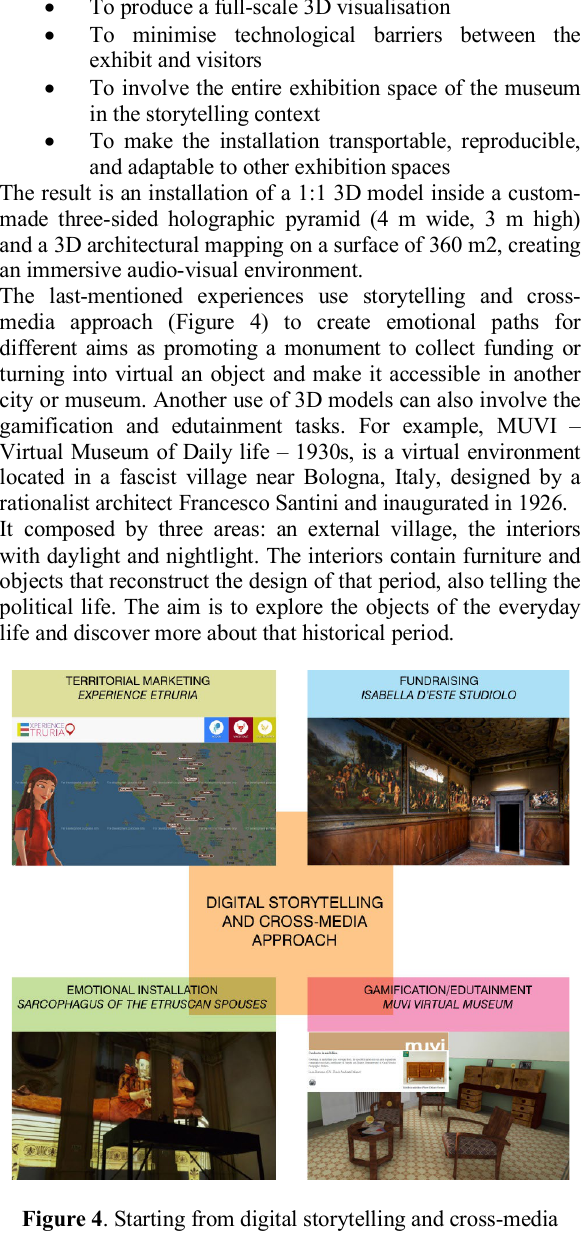
Figure 4 . Starting from digital storytelling and